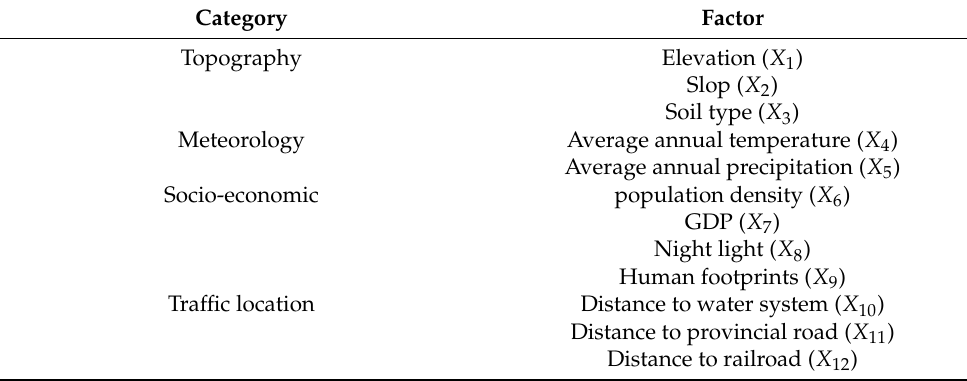
Table 1. Yangtze River Basin SPEI driving